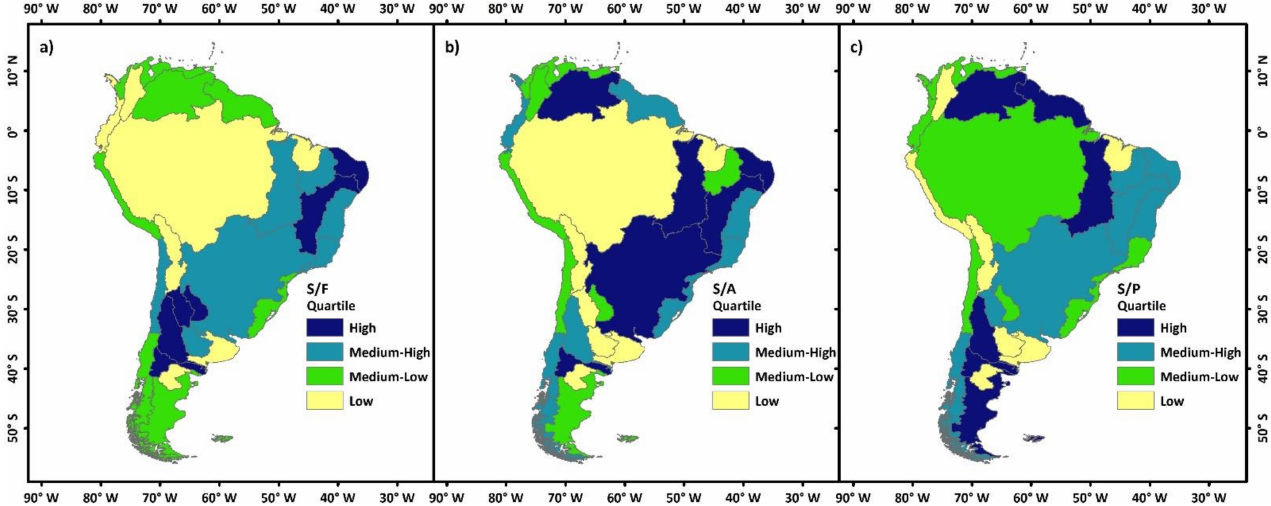
Figure 4. Store ratios per hydrological region mapped as quartiles ( a ) reservoir storage per runoff; ( b ) reservoir storage per area; and ( c ) reservoir storage per person. See Table 2 for specific values for each hydrological